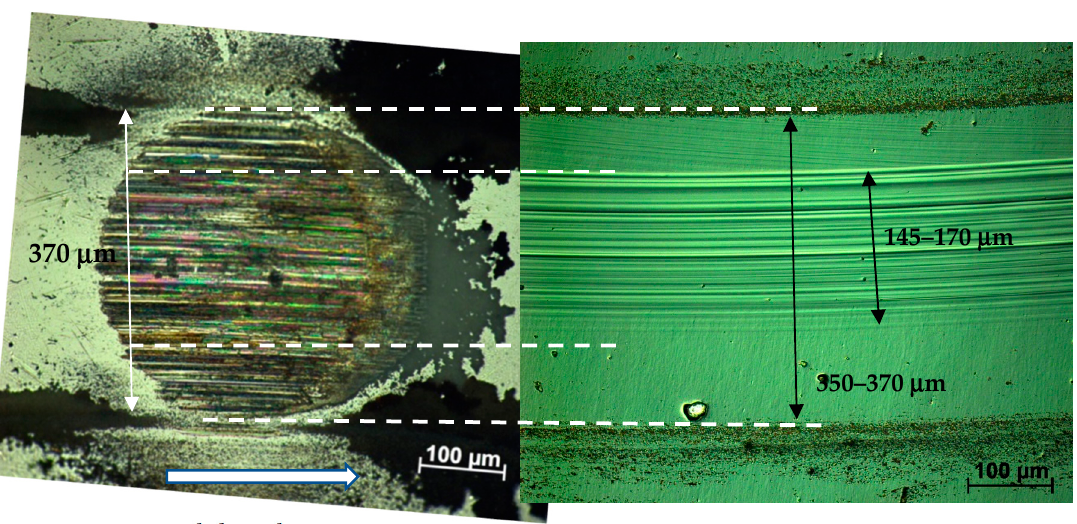
Figure 7. Comparison of the topographies of the wear scar on the steel ball and wear track in HiPIMS W-C:H coating deposited with 3 sccm C 2 H 2 after friction test up to 8400 m in humid air.